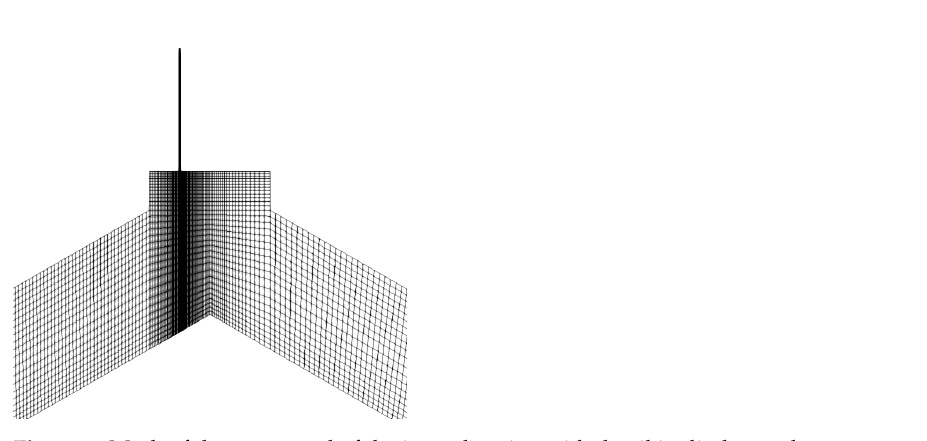
Figure 2. Mesh of the upper end of the irregular pipe with detail in discharge duct.